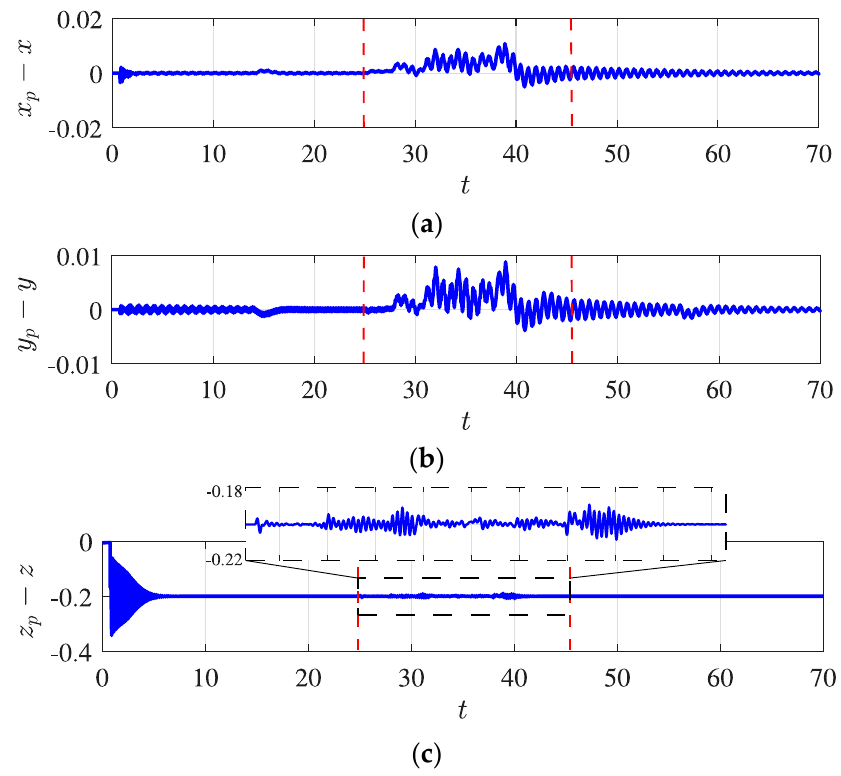
Figure 9. Relative displacement along ( a ) x , ( b ) y and ( c ) z axes, showing the desired trajectory (solid red line) and the external disturbances during a time interval (dashed red line).